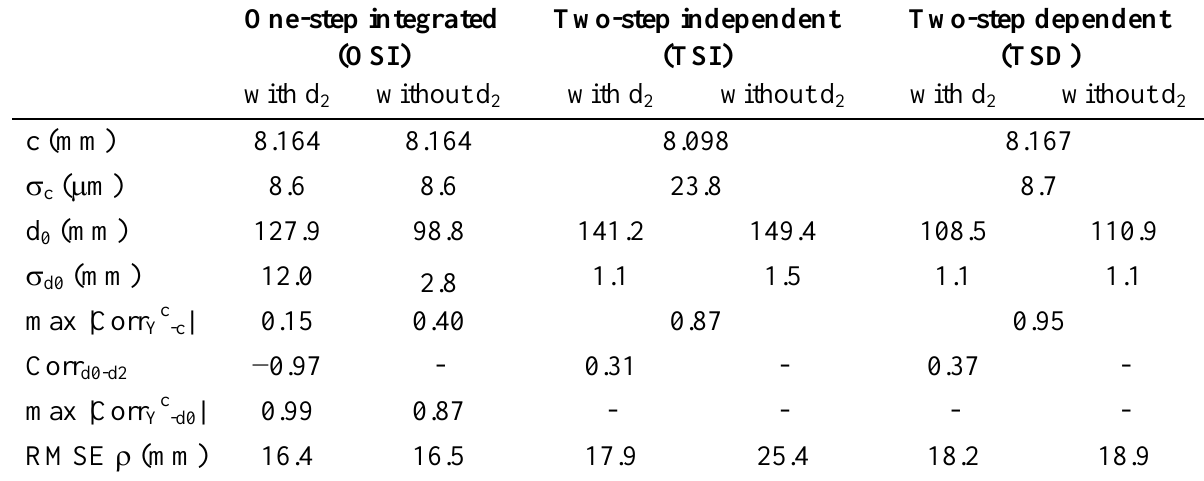
term in the model. 2